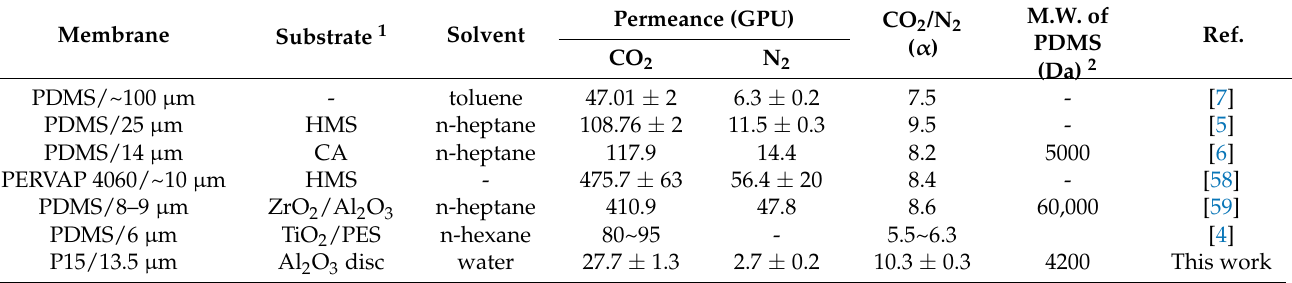
Table 2. CO 2 and N 2 permeances and CO 2 /N 2 selectivity of the PDMS membranes measured in this work compared to those reported in the